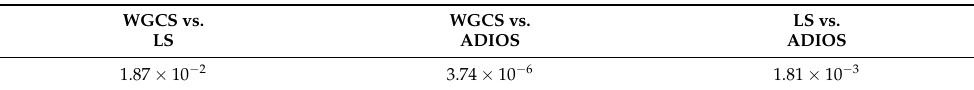
Table 3. Obtained p values for F1 from Wilcoxon signed-rank test. WGCS vs.